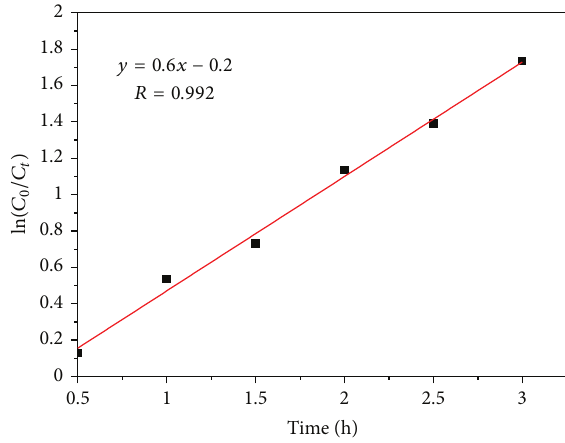
Figure 7: Relation curve of ln (𝐶 0 /𝐶 𝑡 ) and time ( 𝑡